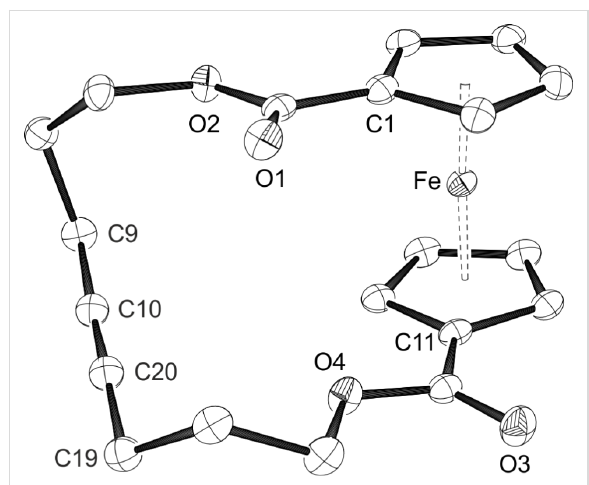
Figure 6: ORTEP diagram of 2b (one of two molecules of the asym- metric unit) with thermal displacement parameters drawn at 50% prob- ability; hydrogen atoms are omitted for clarity. Selected bond lengths [Å] and angles [°]: Fe–Ct1 1.6558(2), Fe–Ct11 1.6548(2), Ct1–Fe–Ct11 176.83(2), C10–C20 1.198(3), C9–C10–C20 177.6(2), C10–C20–C19 179.1(2).